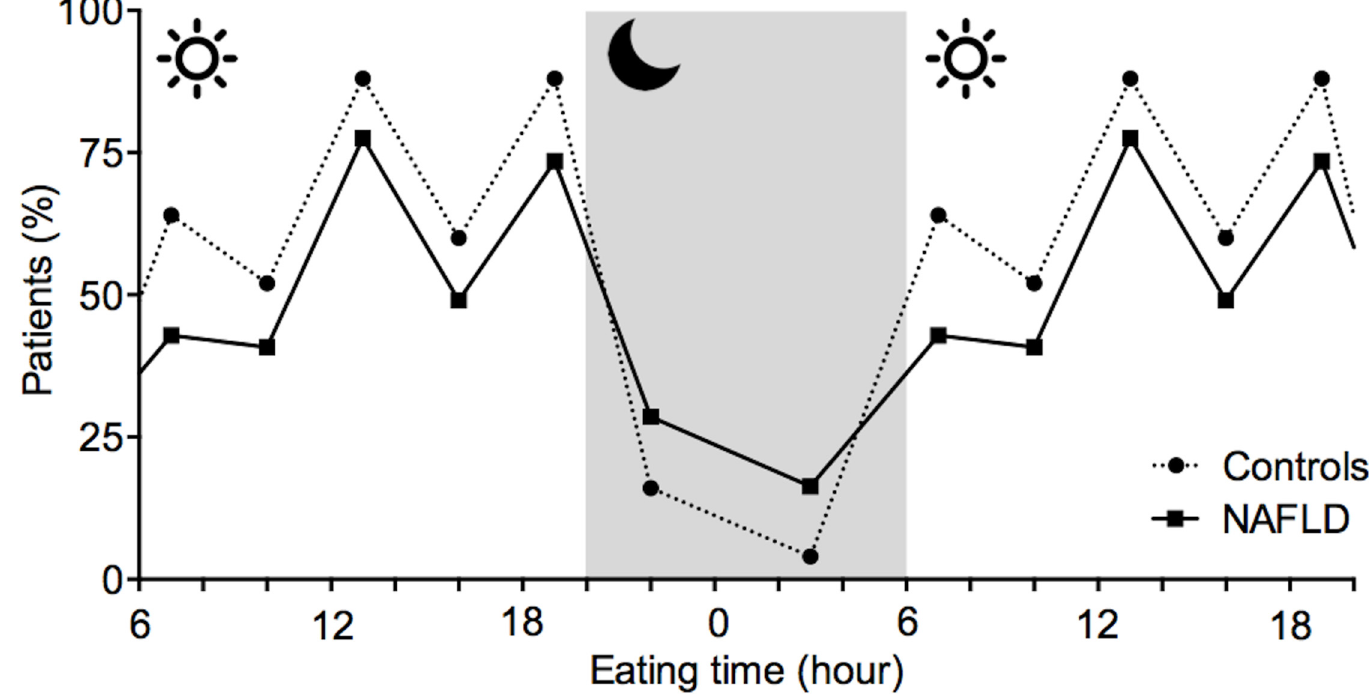
Fig 2. Timing of food-intake differs between NAFLD patients and controls. The percentage of patients vs. controls having meals at different times during the day and night. Compared to controls meal times in NAFLD patients were shifted towards the night (p = 0.001, generalised linear mixed model). Controls (n = 22); NAFLD (n =